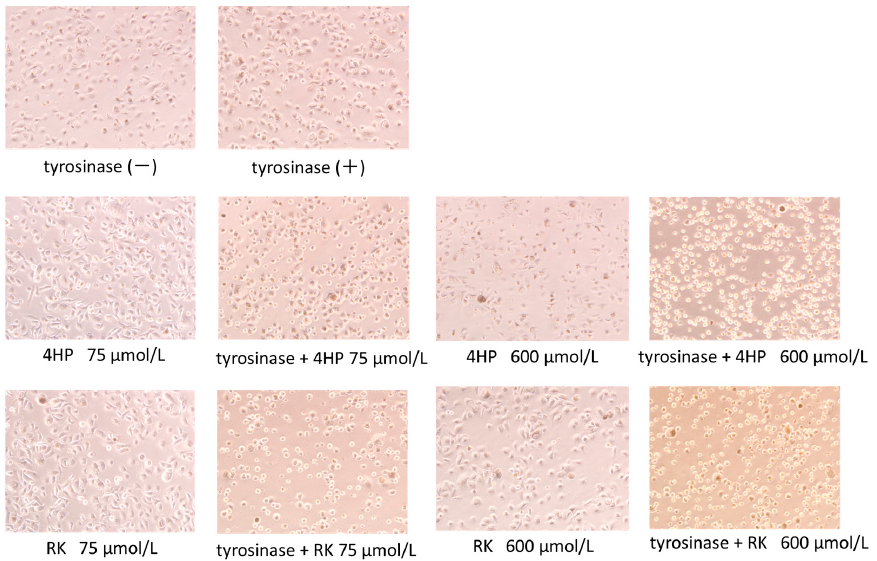
Figure 3. Micrographs of pigment cells showing cytotoxicity of 4HP and RK. Micrographs taken 3 h after 4HP (150 µmol/L) or RK (150 µmol/L), with or without tyrosinase added to the medium. 4HP, rhododendrol; RK, raspberry ketone.